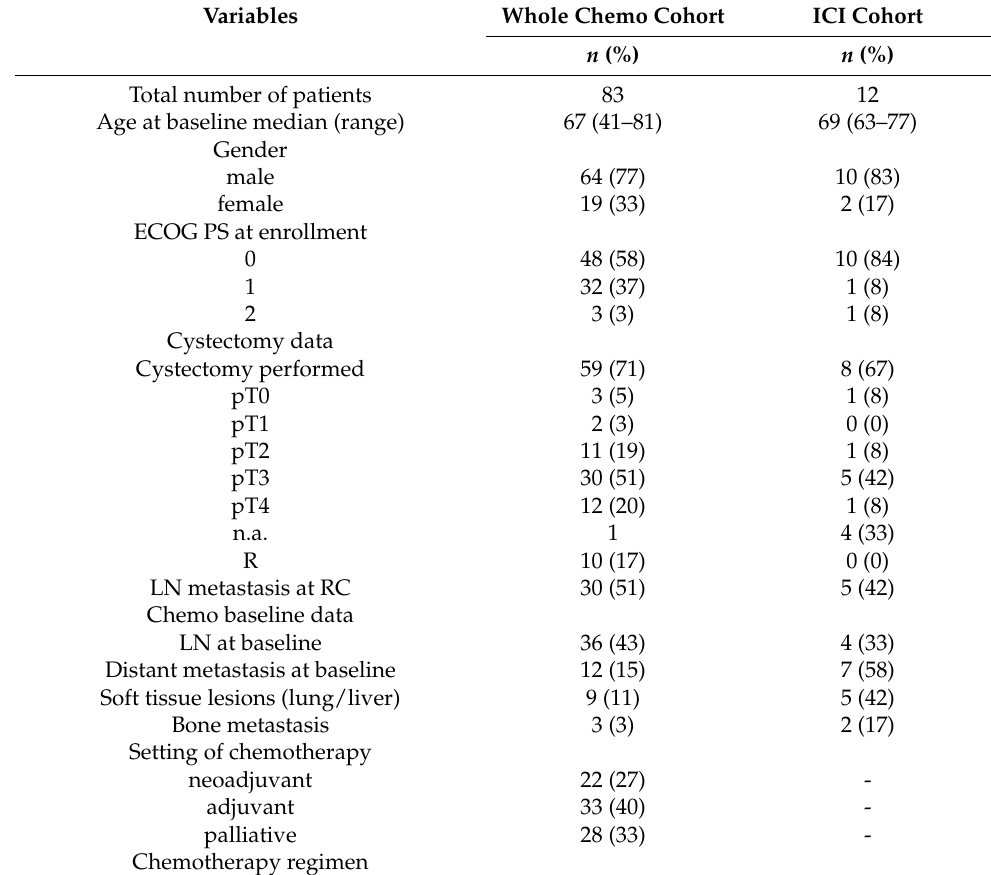
Table 1. Patients’